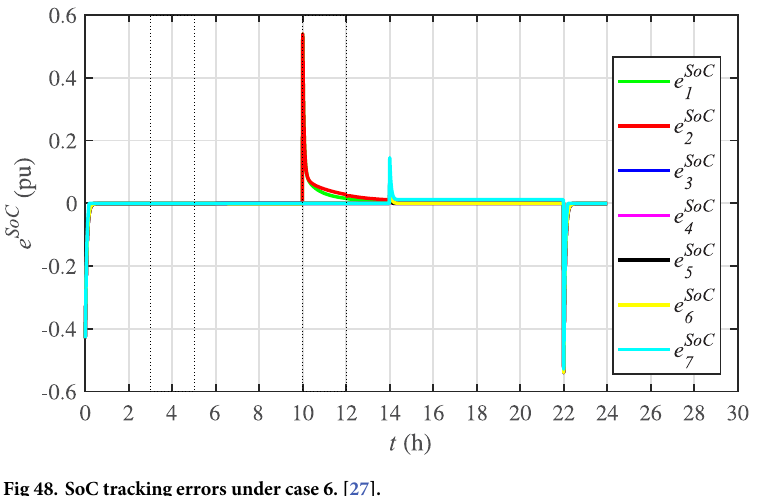
Fig 48. SoC tracking errors under case 6.